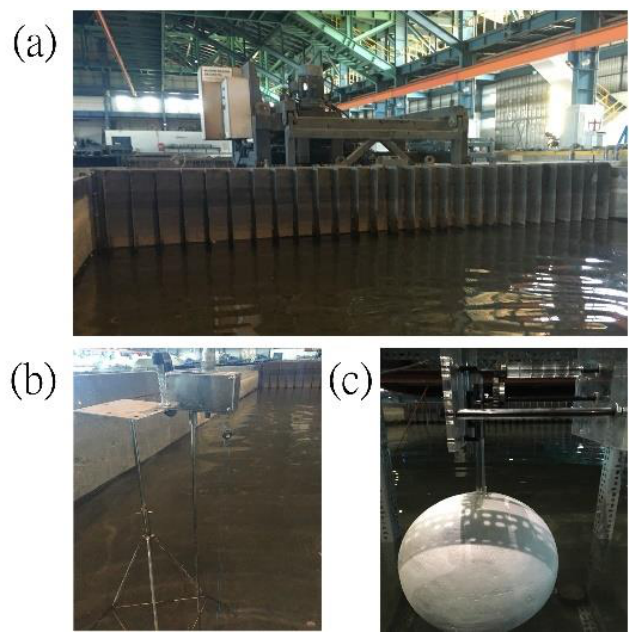
Figure 9. Experimental setup of the PDPWEH in the wave flume.